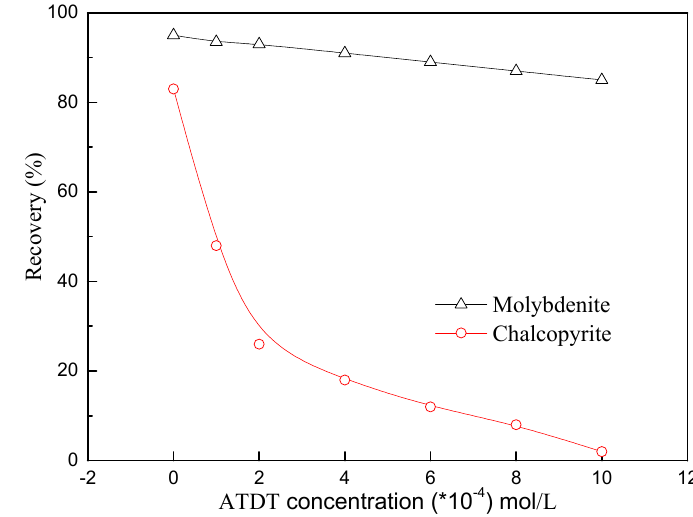
Figure 3. The flotation recovery of molybdenite and chalcopyrite as a function of ATDT concentration by Kerosene (200 mg/L) and MIBC (80 mg/L) at pH 8.0.